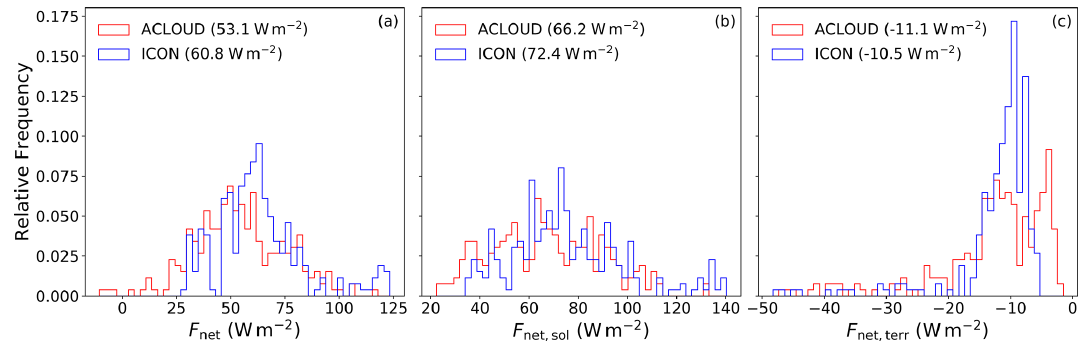
Figure 3. Relative frequency distributions of (blue) modeled and (red) observed surface net irradiation for sea-ice-covered surfaces and cloudy conditions for (a) total radiation, (b) solar, and (c) terrestrial radiation. Values in the legend indicate the median of the respective